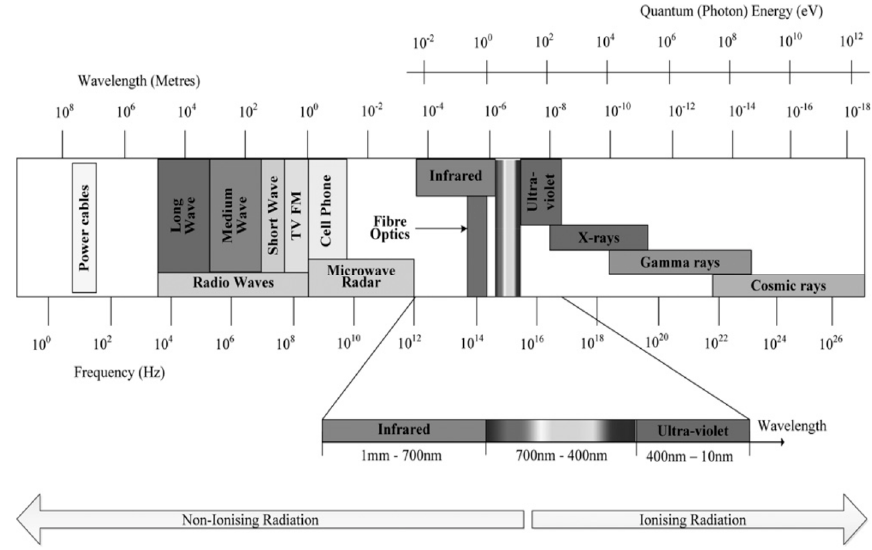
Figure 1. Electromagnetic spectrum range.